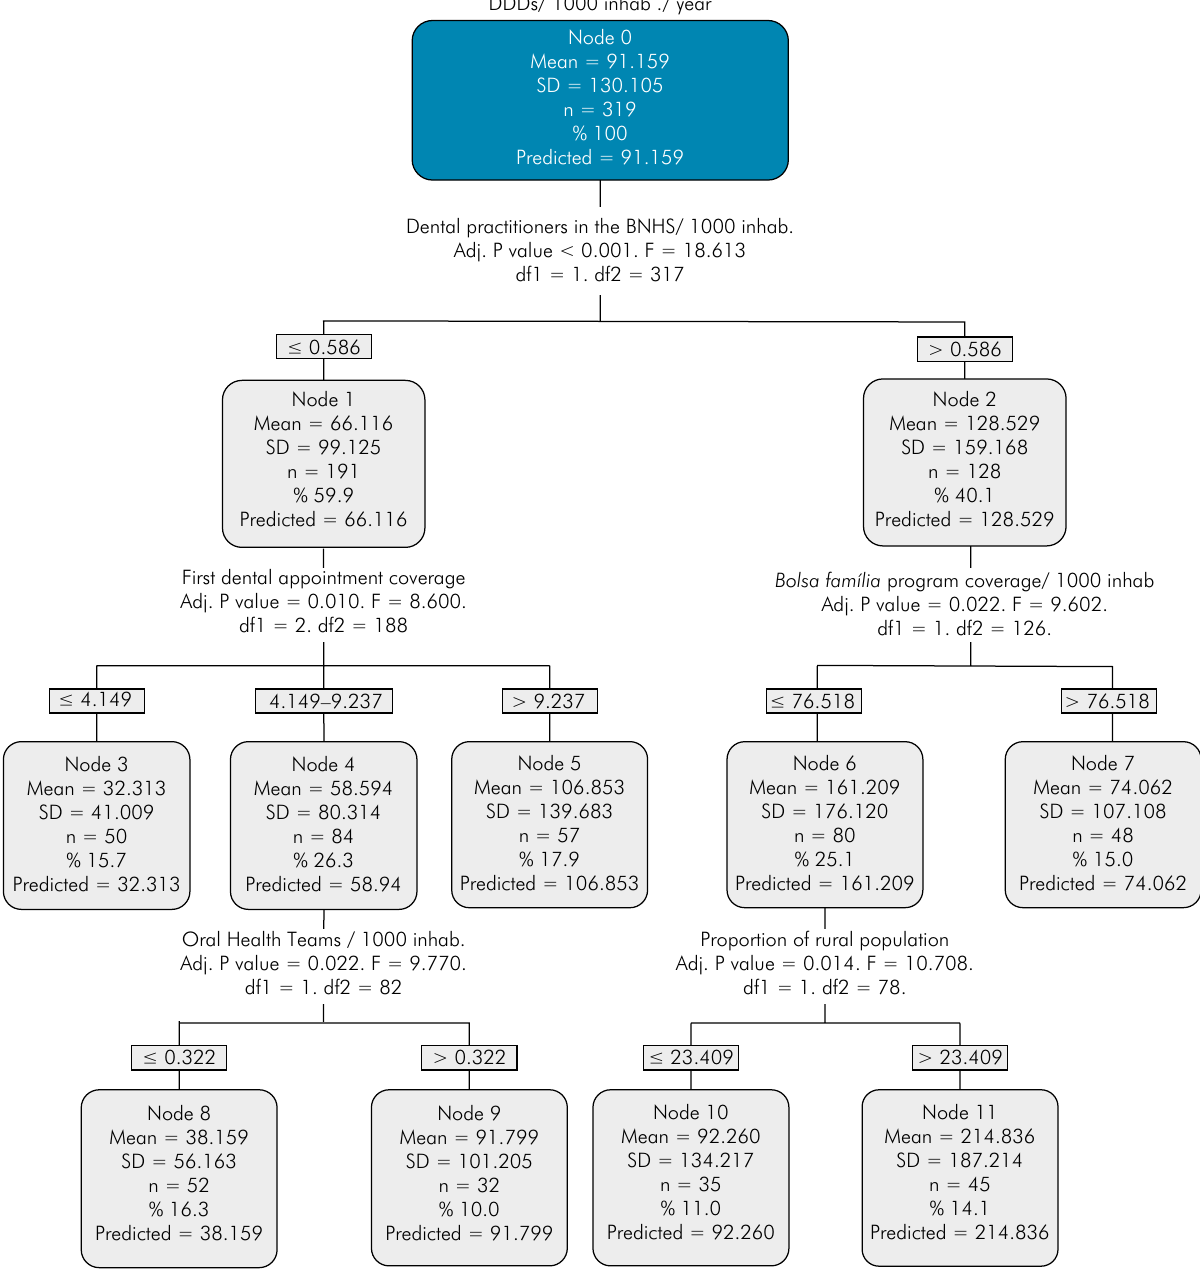
Figure 1. CART analysis for non-steroidal anti-inflammatory